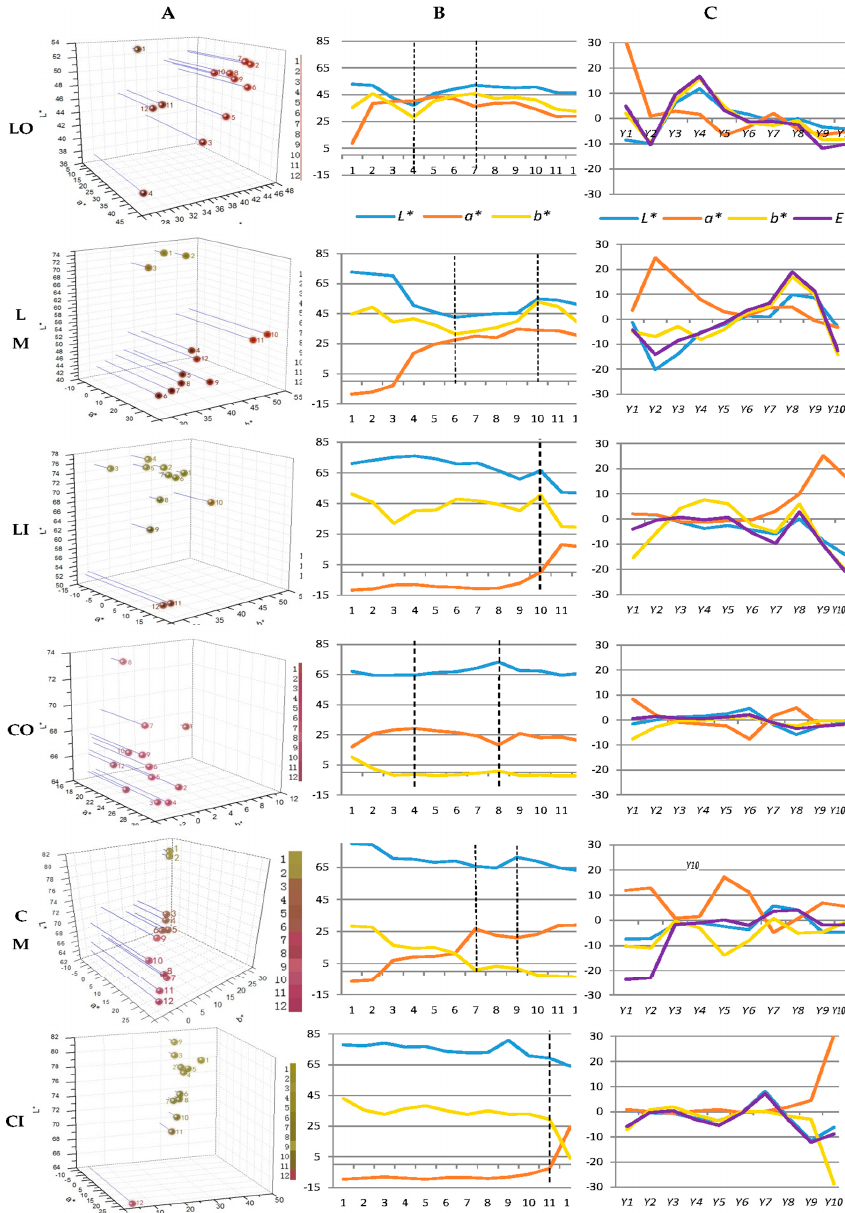
Figure 2. Colorations and corresponding model of change dynamics of petals of three layers at 12 development stages. L-O, L-M, and L-I: outer, middle, and inner layers of petals of ‘Jiaoyan zhuanhong’, respectively; C-O, C-M, and C-I: outer, middle, and inner layer of petals of ‘Jiaoyan yanghong’, respectively; ( A ) CIE systems of colorations, in each individual figures, balls named 1–12 reflected the colors of the 12 development stages (Figure 1), and corresponding color chars were shown in the right; ( B ) measurements of L *, a * and b * at 12 stages; ( C ) model of change dynamics of petal (cid:17) (cid:16) (cid:17) (cid:105) (cid:104) (cid:16) (cid:82) j + 1 · v pj + t − t j v p , j + 1 − v pj dt · ε / ( t j + 1 − t j ) colorations: Y jv = , where measurements of j 1 + e − apj L *, a *, b * as well as E* of two varieties were recorded as l (Jiaoyan zhuanhong) or c (Jiaoyan yanghong), (cid:16) (cid:17) t j + 1 i.e., l p , j + 1 = l p , ( p = outer petal, middle petal or inner petal; j + 1 = stage 1, . . . ,12 ) ; v pj = (cid:12) (cid:12) l p , j + 1 − l pj v p , j + 1 − v pj (cid:12) (cid:12) ; a pj = (cid:12) (cid:12) ; Y1–Y10: corresponded to stage 3–stage 12; negative or positive values of t j + 1 − t j t j + 1 − t j Y jv indicated corresponding status of coloration changes were decreasing or increasing, respectively; big Y jv indicated the tendency was toward great changes while small Y jv meant changes became